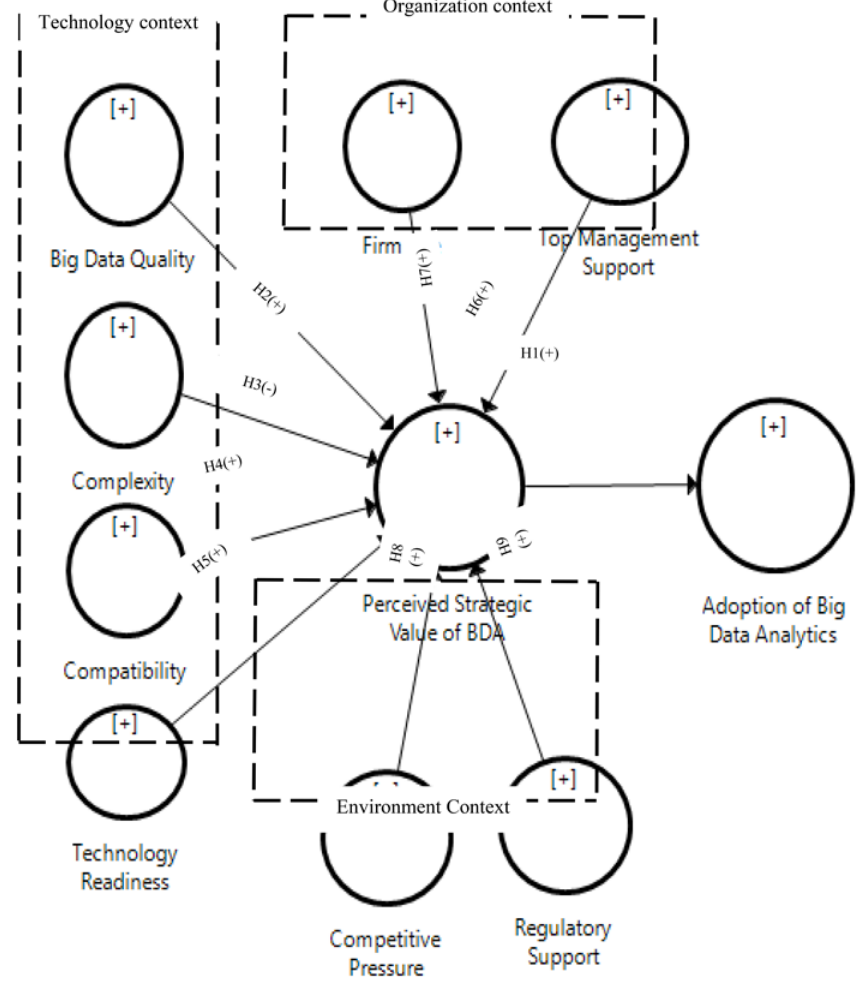
Figure 1 Proposed research